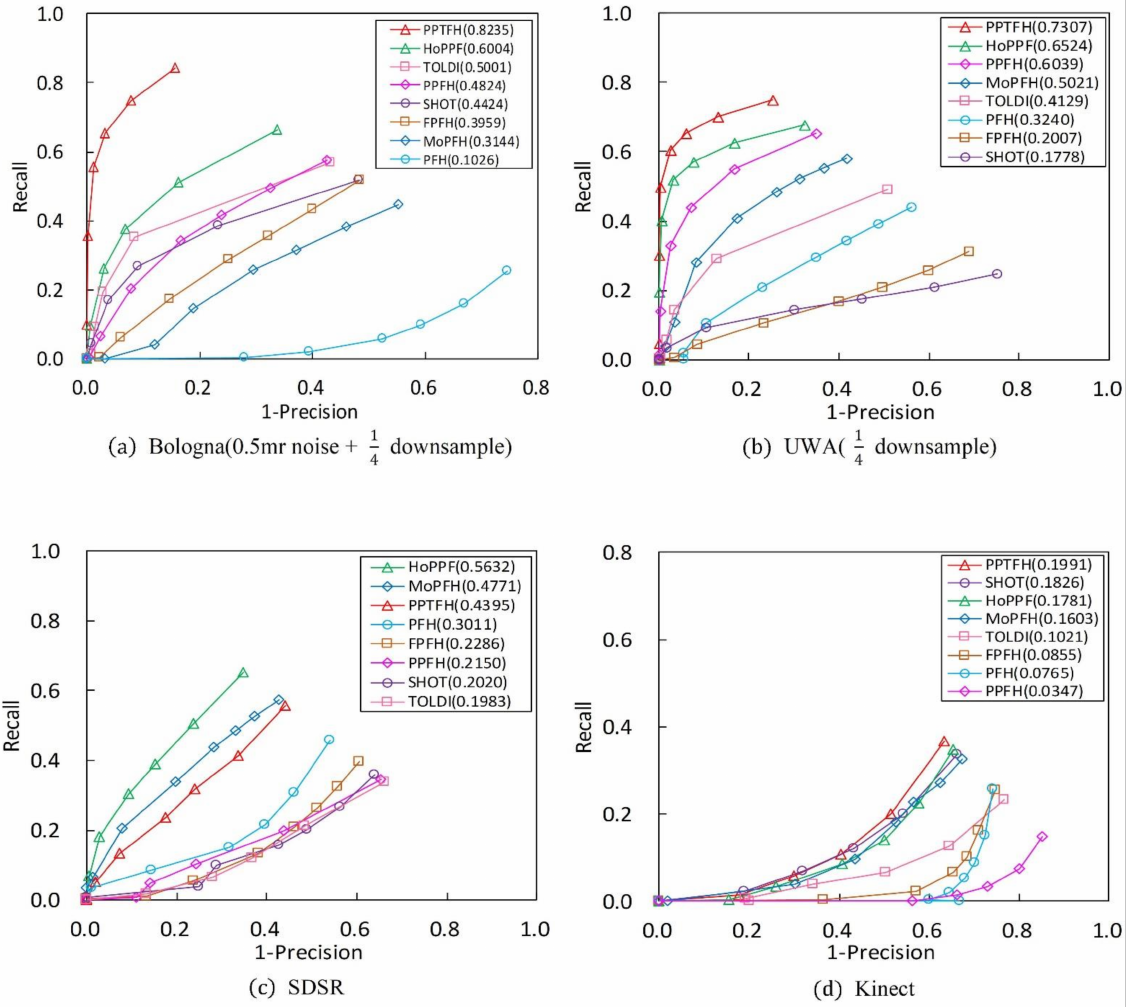
Figure 7. RPC results on 4 different application datasets (AUC pr values are exhibited in parentheses). ( a ) Bologna dataset with 0.5 mr noise and 1/4 downsample. ( b ) UWA dataset with 1/4 downsample. ( c ) SDSR dataset for registration. ( d ) Kinect